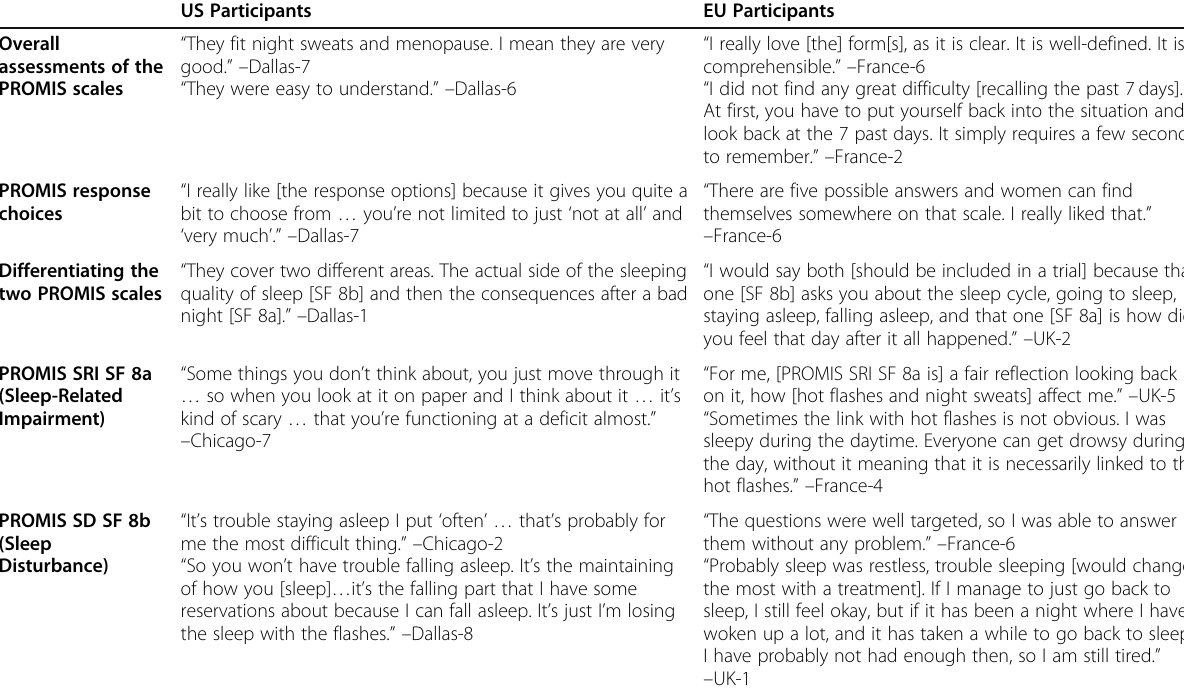
Table 7 Representative quotations from the cognitive debriefing phase related to PROMIS SRI SF 8a (Sleep-Related Impairment) and PROMIS SD SF 8b (Sleep